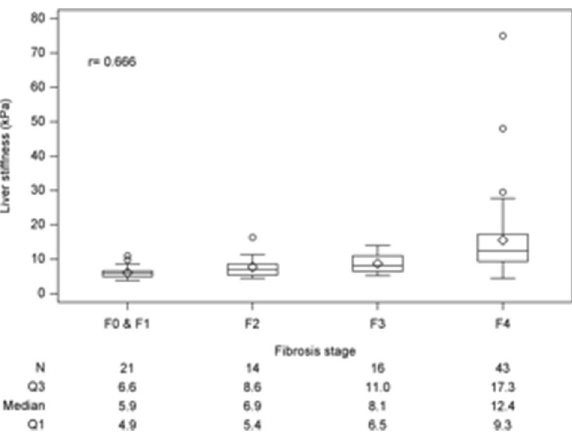
Figure 2. Liver stiffness correlated with histological fibrosis stage (F) positively (r = 0.666).